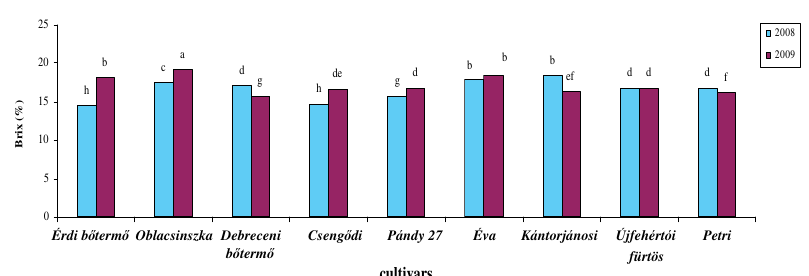
Figure9 . Brix of the studied sour cherry cultivars in tow years (2008 & 2009). Different letters indicate significant differences between treatments (P